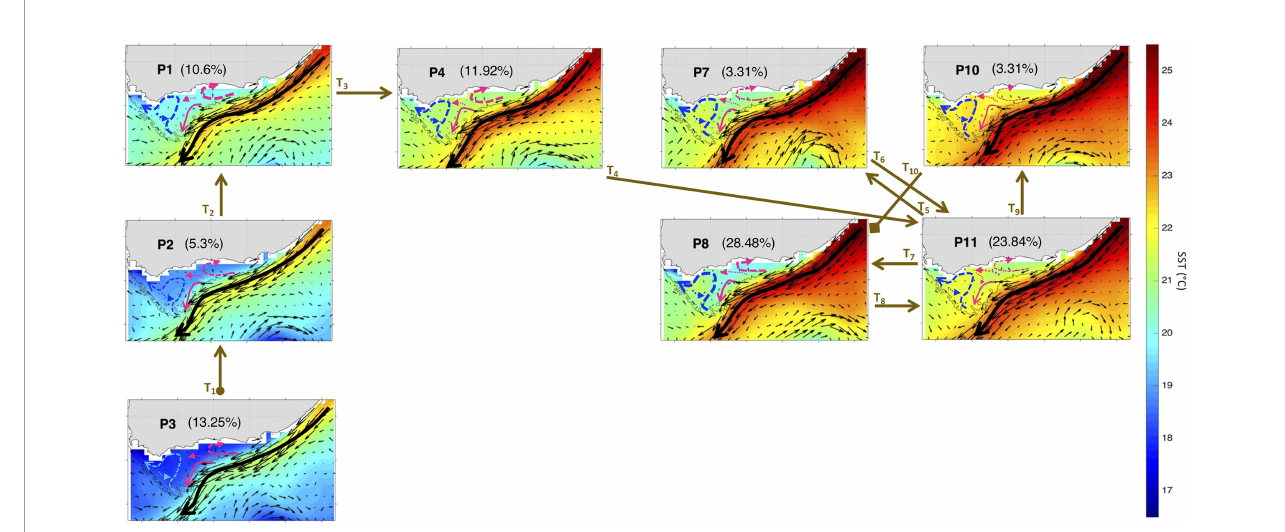
FIGURE 6 | Same as Figure 3 but for Nov-Mar 2016-17. The frequency of occurrence of each pattern is calculated here relative to the days recorded during Nov-Mar 2016-17. The brown arrows represent the SOM patterns trajectories (T i=1:10 ) evolving during Nov-Mar 2016-17as inferred from the BMU timeseries ( Supplementary Figure 4A ). The starting ( fi nal) trajectory is designated with a circle (diamond) at the arrow beginning (end).